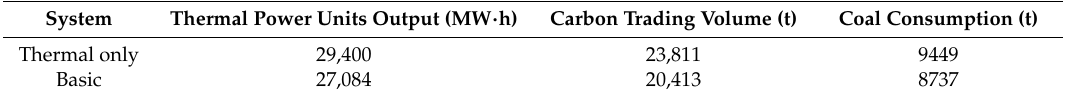
Table 5. The thermal power comparative results in both situations.